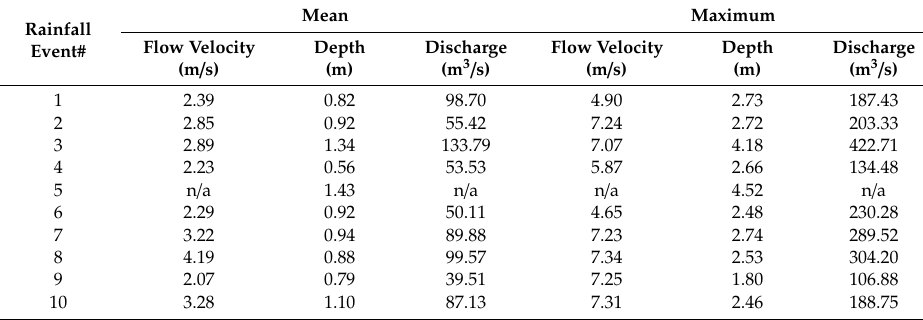
Table 2. Basic runo ff characteristics of the rainfall events in Table 1.